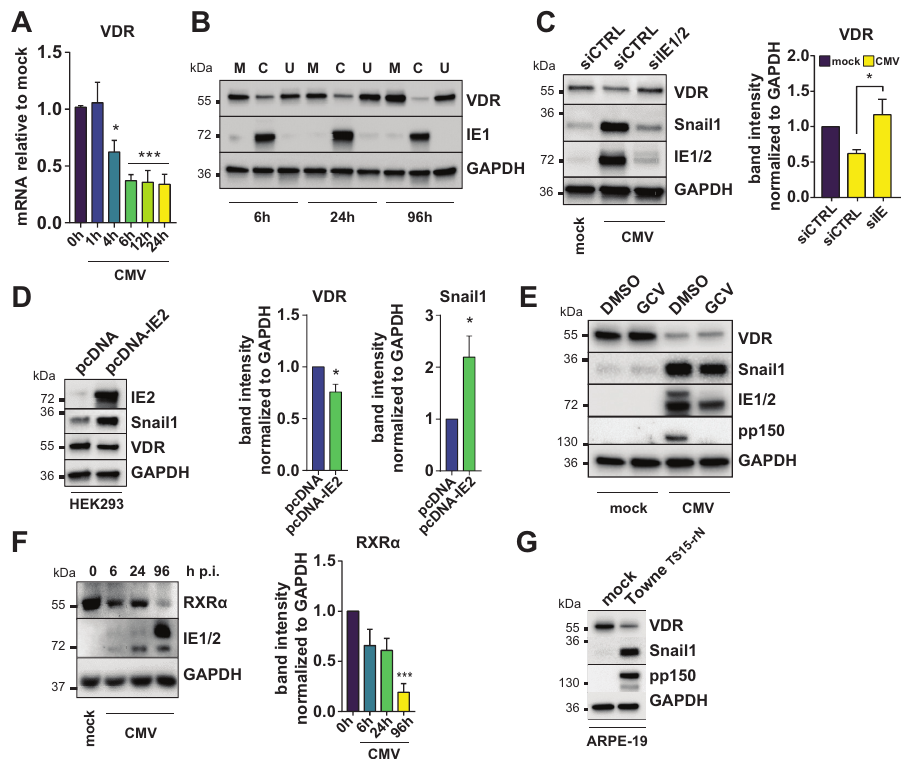
Figure 3. VDR holoenzyme downregulation is dependent on immediate early gene transcription. ( A ) Vitamin-D-receptor expression was measured in mock- or HCMV-infected HFF at the indicated time points, showing fold change (2 − ∆∆ Ct) compared to mock-infected cells (mean ± SEM). Asterisks indicate significant differences to the mock control sample as determined by ANOVA Dunnett’s multiple comparison post-hoc test. ( B ) VDR, IE1 (pp72) and GAPDH protein expression were determined by Western blot in HFF that were infected with mock (M), CMV (C) and UV-inactivated CMV (U) inocula and harvested at the indicated times post infection. ( C ) VDR and HCMV immediate early protein expression was determined in lysates of HFF transfected with a non-targeting control siRNA or IE1/2 specific siRNA harvested at 24 h p.i. Representative blot (left) and quantification of bands from multiple experiments relative to the GAPDH loading control (right). Asterisks indicate significant differences to the CMV siCTRL sample as determined by ANOVA Dunnett’s multiple comparison post-hoc test. ( D ) HEK293 cells were transfected with pcDNA empty vector control or pcDNA containing the IE2 open reading frame. Lysates were analyzed by Western blot at 48 h post transfection. Asterisks indicate significant differences to empty vector control (unpaired t-test). ( E ) VDR and Snail1 expression was determined at 96 h p.i. in lysates of HFF treated with vehicle (DMSO) or 10 µ g/mL Ganciclovir (GCV). HCMV immediate early and pp150 late antigens were stained as a control. ( F ) RXR α protein expression in HFF was determined by specific immunoblots at the indicated time points p.i. Representative blot (left) and quantification of bands from multiple experiments relative to the GAPDH loading control (right, one-way ANOVA and Dunnett’s post-hoc test). ( G ) ARPE-19 cells were infected with mock supernatant or the pentamer-positive (TS15-rN) variant of the Towne strain and harvested 14 d p.i. VDR, Snail1, pp150 late antigen and a GAPDH loading control detection by Western blot is